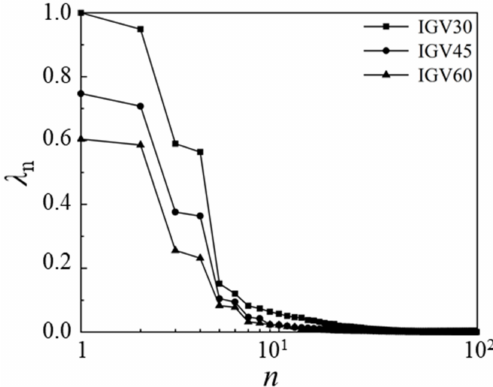
Figure 14. Normalized eigenvalues of the first 100 POD